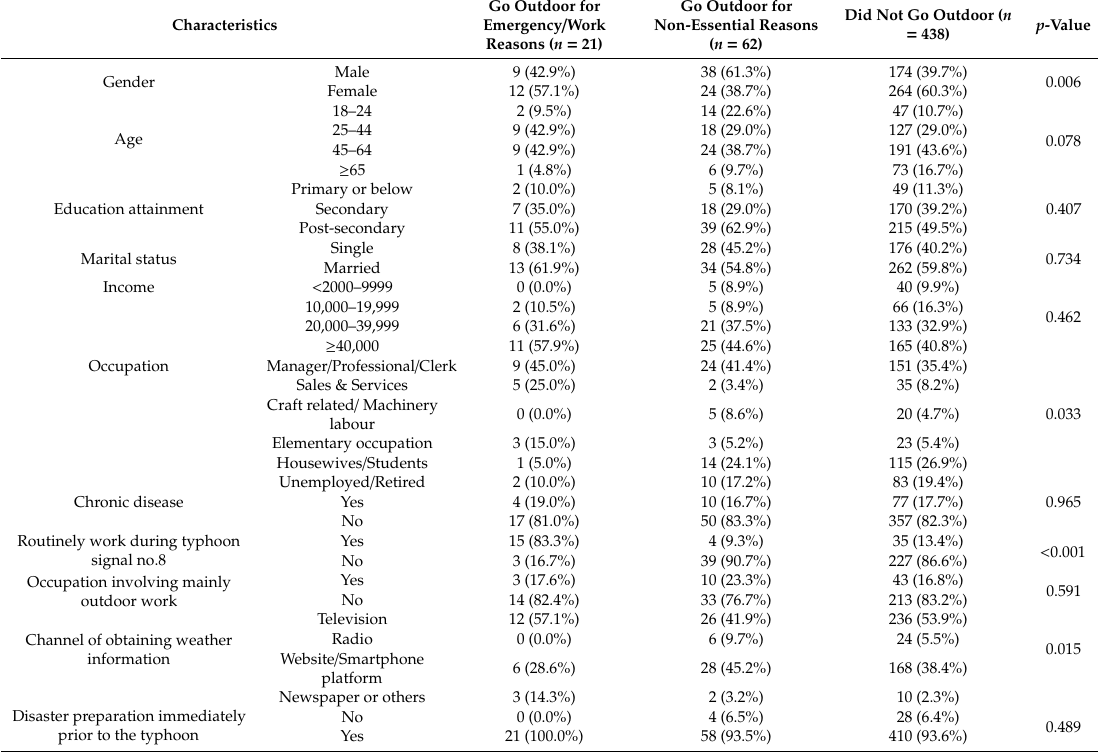
Table 1. Descriptive table of the study